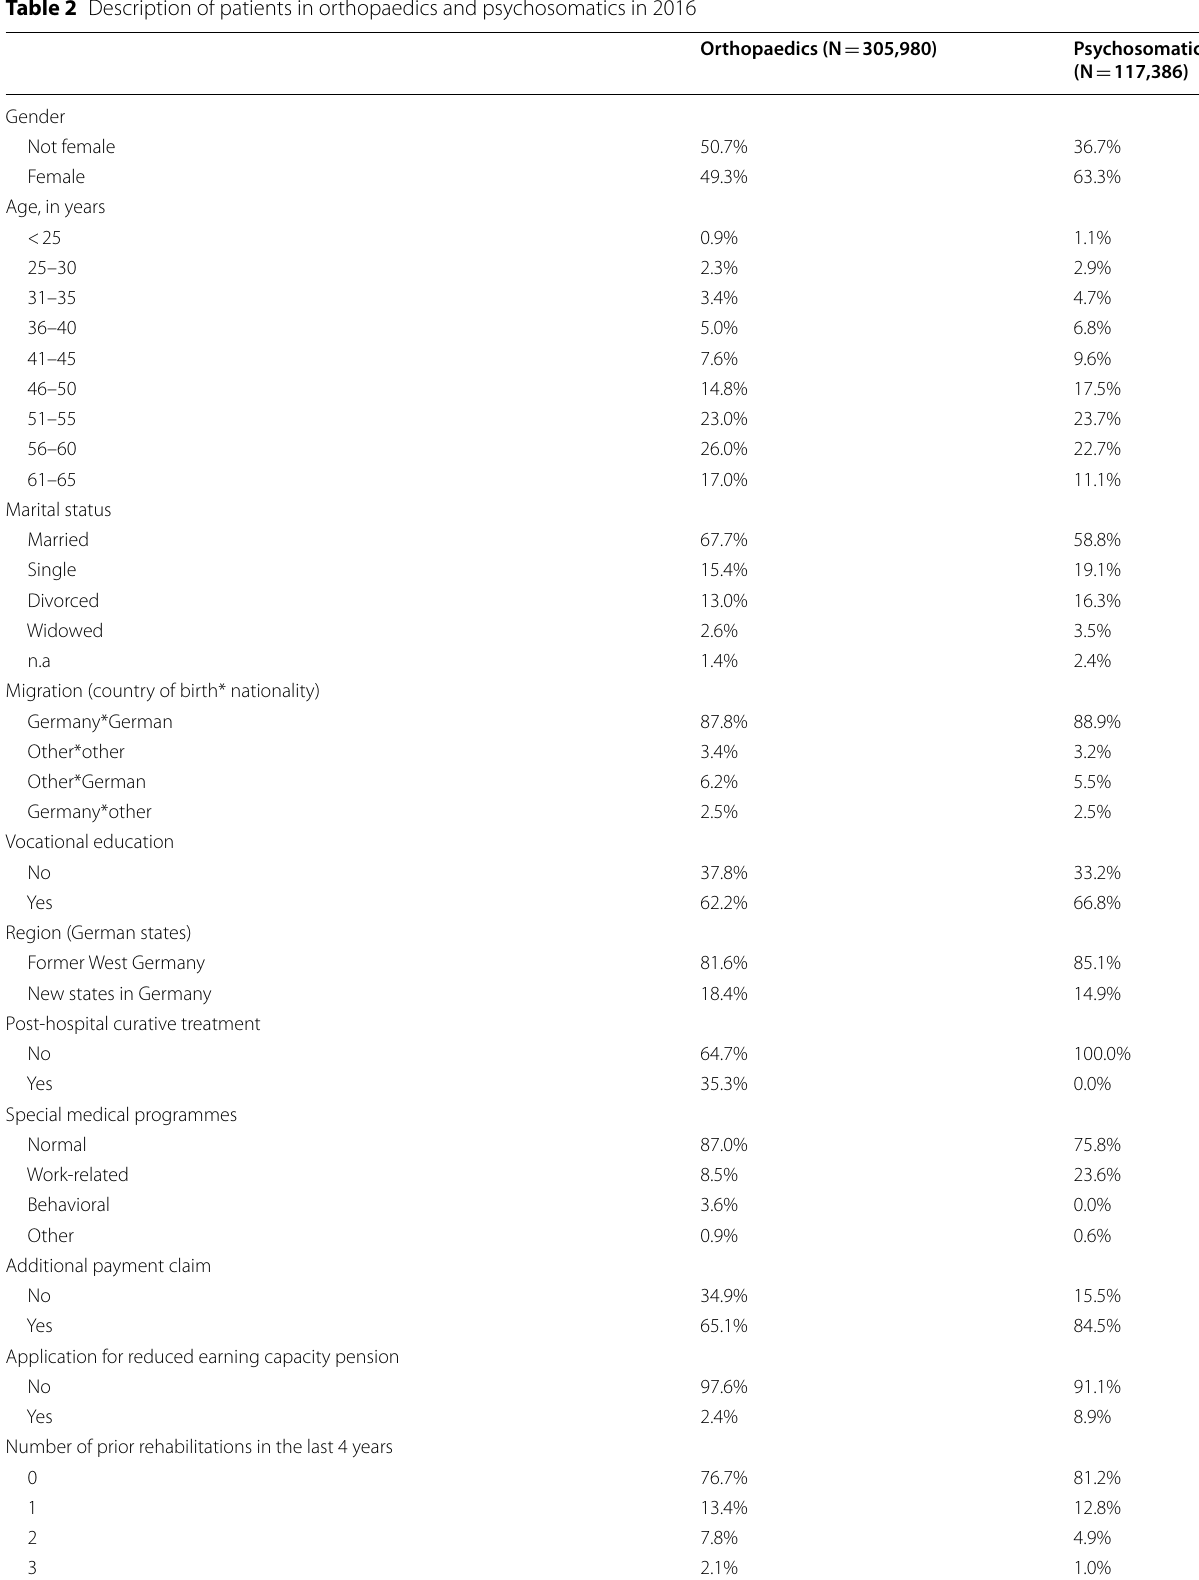
Table 2 Description of patients in orthopaedics and psychosomatics in